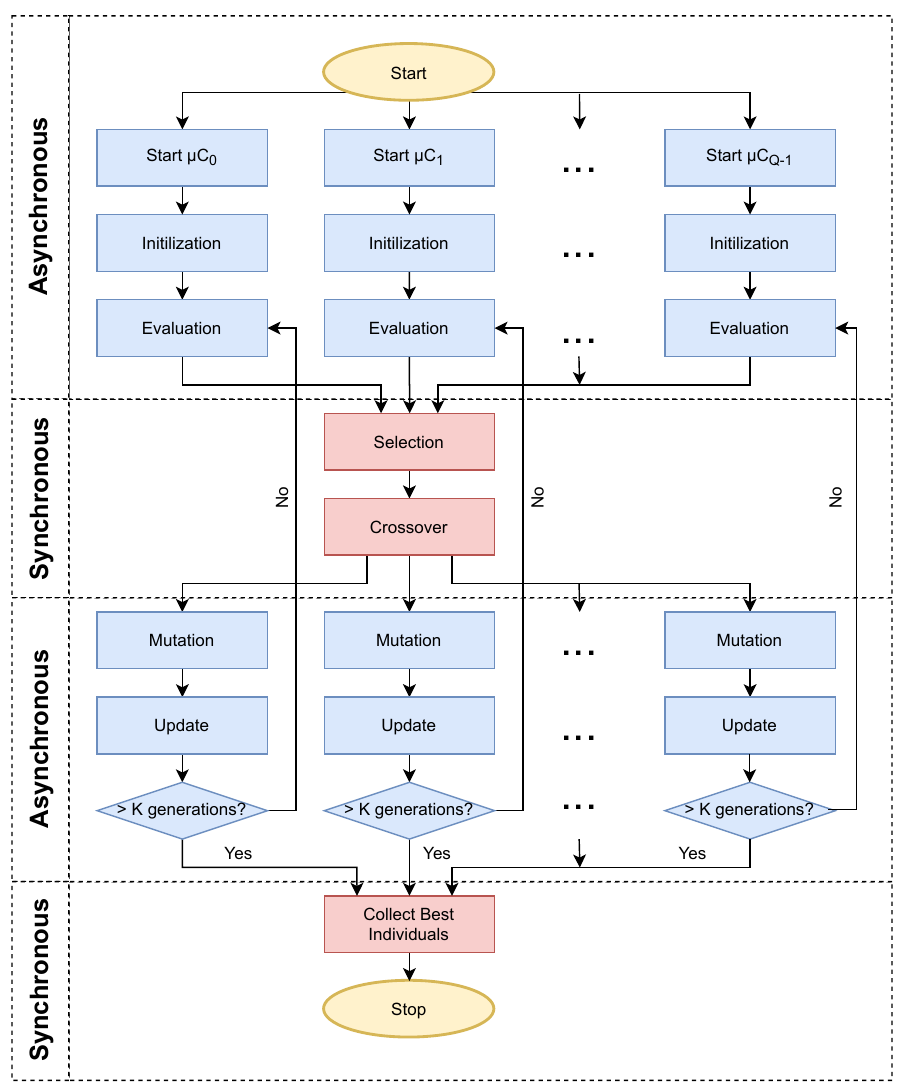
Figure 6. Master-slave distributed GA model proposed by this work for distributed genetic algorithms showing asynchronous and synchronous